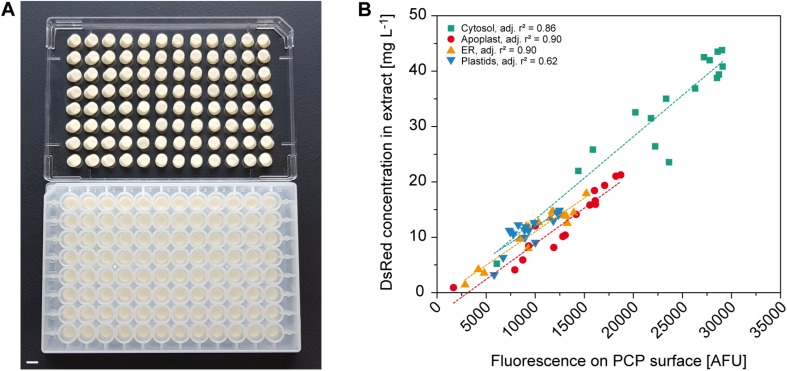
Automated readout of surface fluorescence from PCPs in 96-well plates. (A) PCPs in an AgroPrep Advance filter plate after the removal of BY-2 culture medium (bottom) and after inverted centrifugation for clarification of dimensions and pack integrity (top). Scale bar = 5 mm. (B) Correlation between fluorescence on PCP surface (excitation = 559 nm, emission = 585 nm) and DsRed concentration in extracts prepared from the same PCPs transiently expressing DsRed in the cytosol, apoplast, endoplasmic reticulum (ER) or plastids 4 days after infiltration (n = 16). Dotted lines show linear fit per compartment.